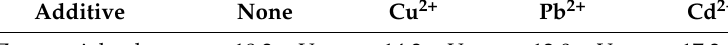
Table 1. Zeta potentials of polyDOPA-AgNPs interacted with metal ions.